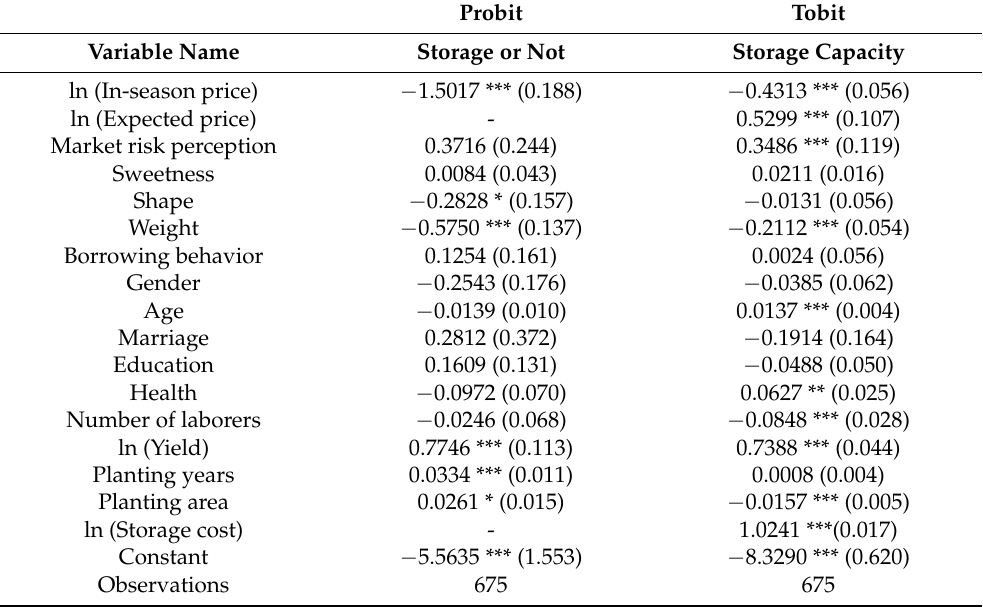
Table 4. Regression results of storage decision behavior of growers in Changxing Town and Baojia